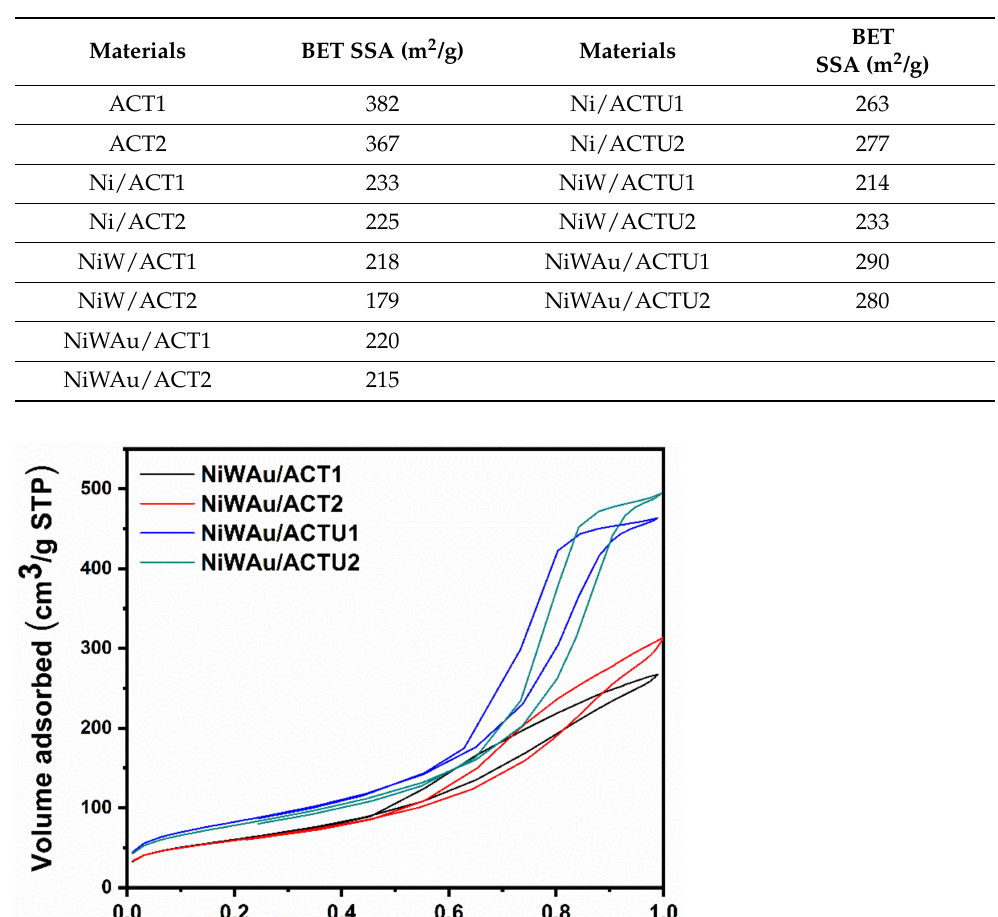
Table 2. BET specific surface area (SSA) of the supports and metallic nanomaterials.